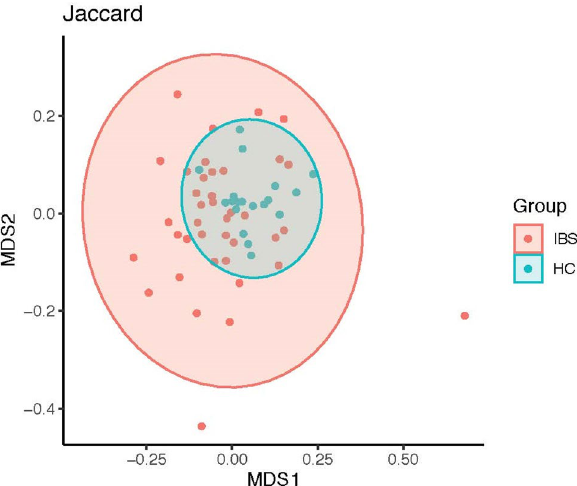
Figure 6. Fecal microbiome dissimilarity using Jaccard distance between IBS and healthy control (HC) groups.